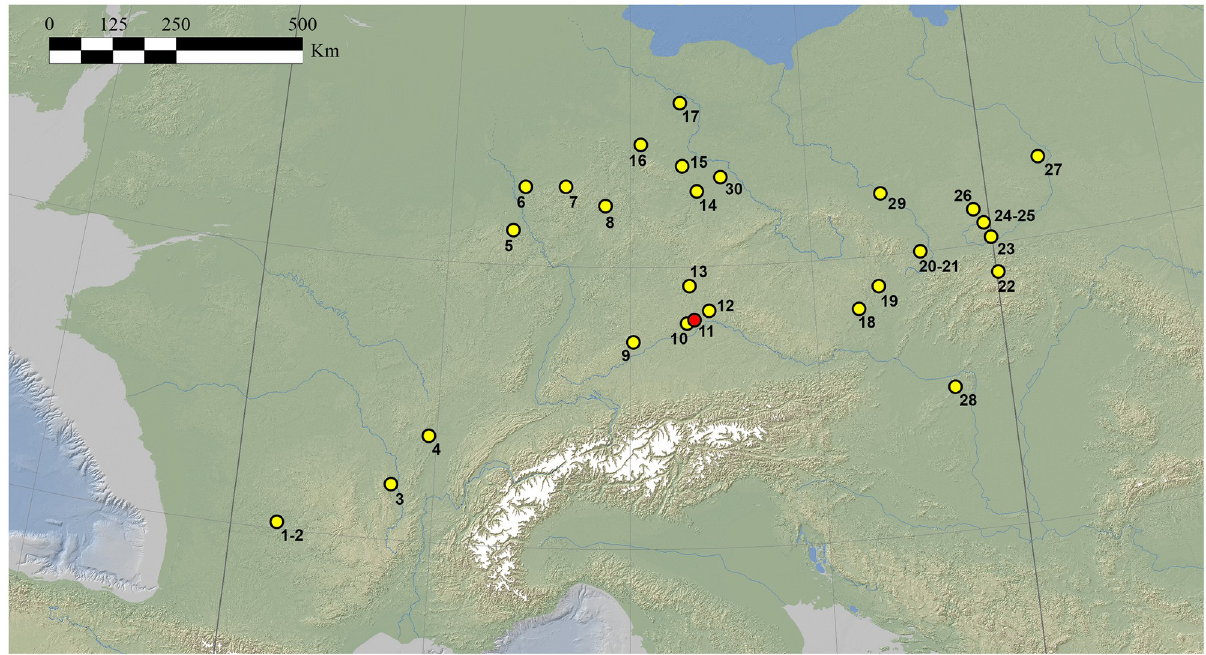
Fig 1. Map of Central-Western Europe during GI 12 (46.8–44.2 ky) with Digital Elevation Model (base topography–ETOPO, 2011; ETRS_1989_LAEA_152 projected coordinate system) developed by Davide Margaritora and location of sites named in the paper: 1) La Micoque; 2) Abri du Muse´e; 3) Champ Grand; 4) Grotte de la Verpilie´re; 5) Kartstein; 6) Neandertal; 7) Balver Ho¨hle; 8) Bu¨hlen; 9) Bockstein-III; 10) Klausennische; 11) Sesselfelsgrotte; 12) Zeitlarn-I; 13) Weinbergho¨hle; 14) Neumark Nord; 15) Ko¨nigsaue; 16) Salzgitter-Lebenstedt; 17) Lichtenberg; 18) Moravsky-Krumlov IV; 19) K ů lna; 20) Dzierzyslaw-I; 21) Pietraszyn 49a; 22) Oblazowa; 23) Zwierziniek; 24) Wylotne; 25) Ciemna; 26) Bisnik; 27) Zwole´n; 28) Tata; 29) Wroclaw-Hallera Avenue; 30)